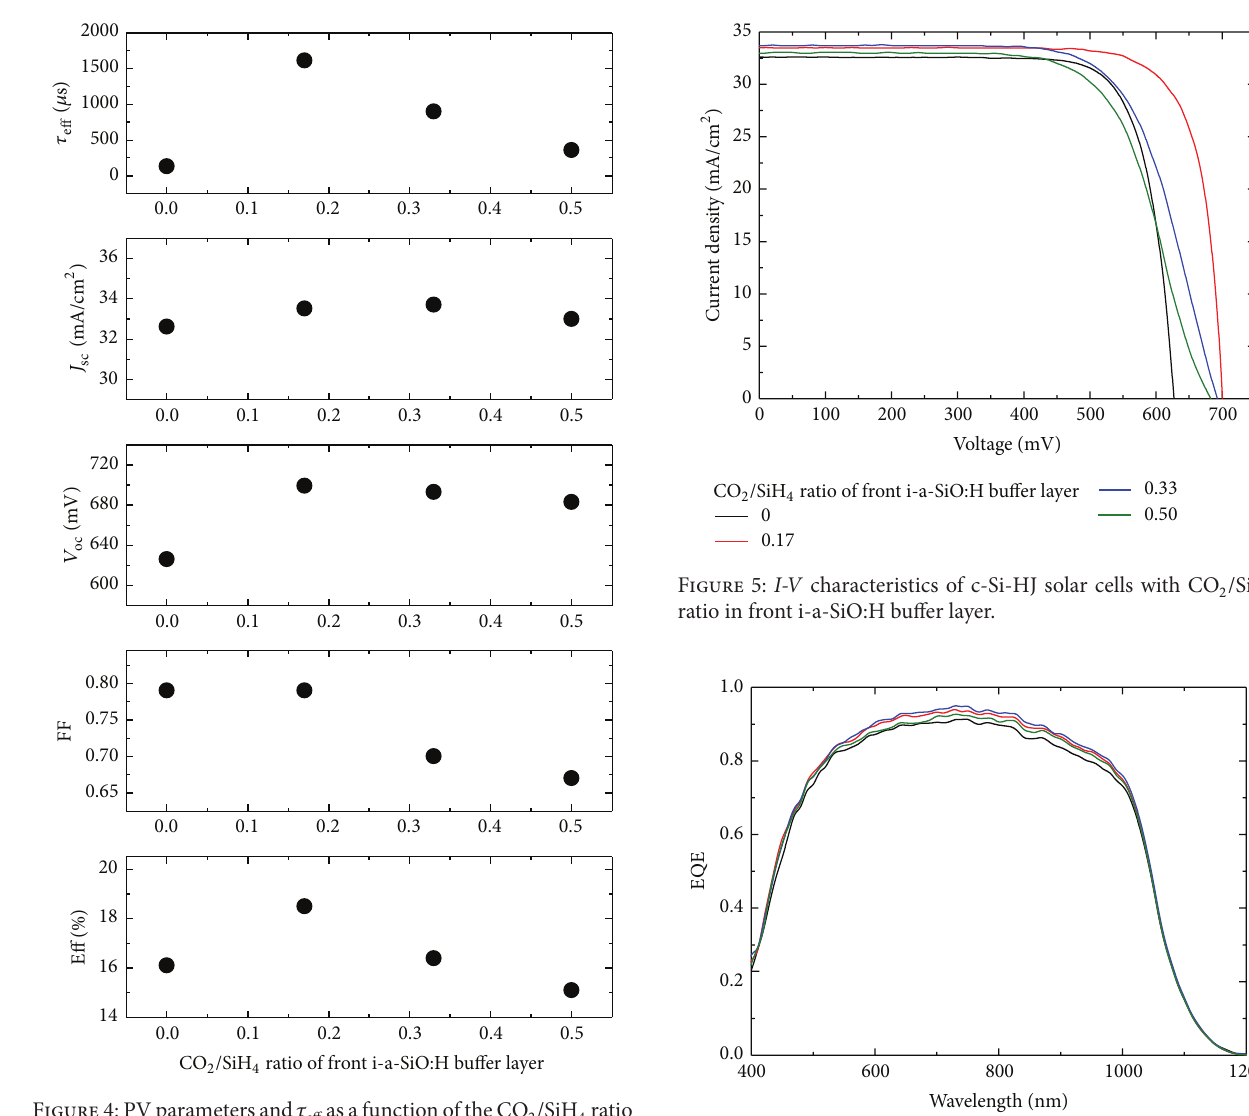
as a function of the CO 2 /SiH 4 ratio eff